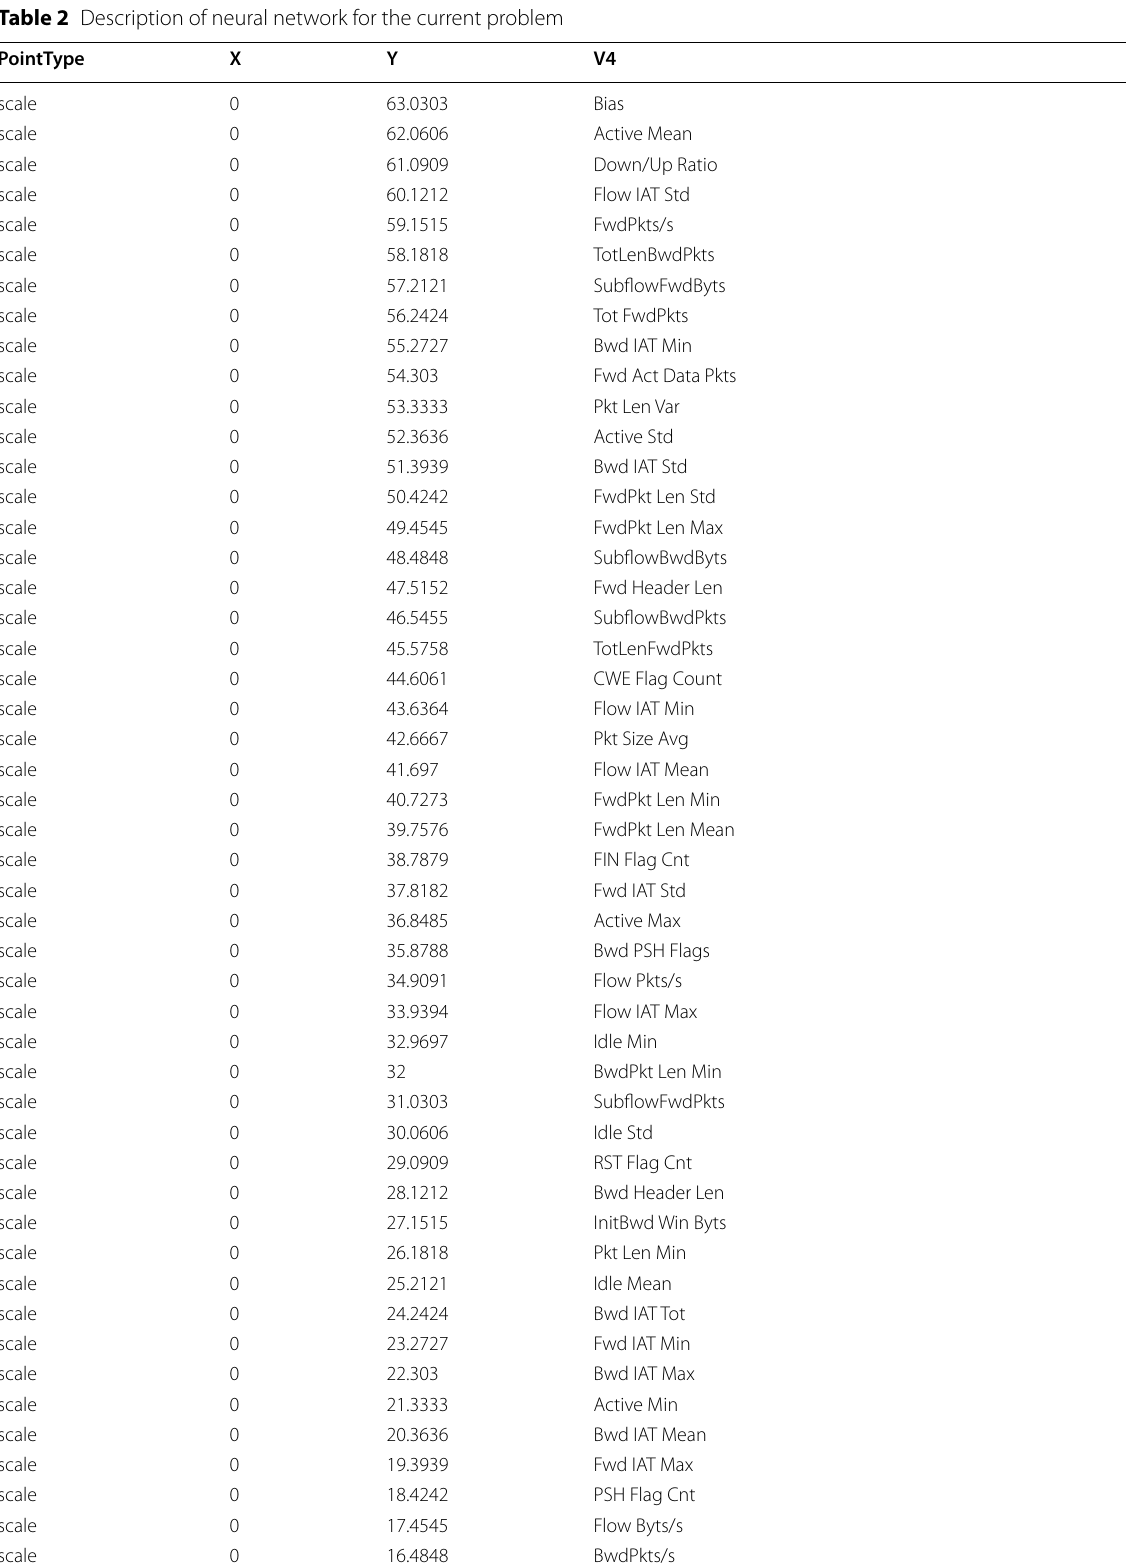
Table 2 Description of neural network for the current